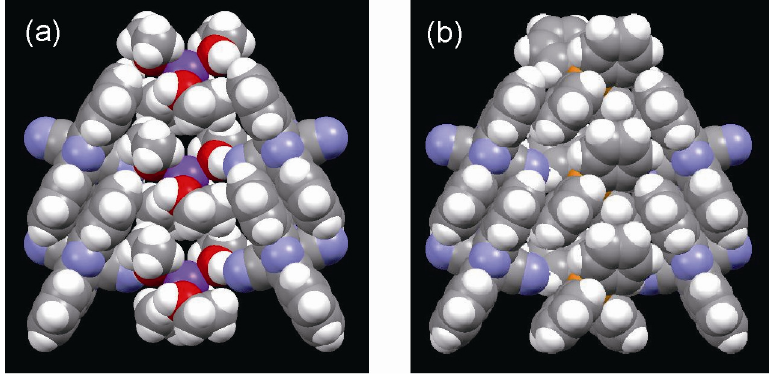
] with space filling 2 2